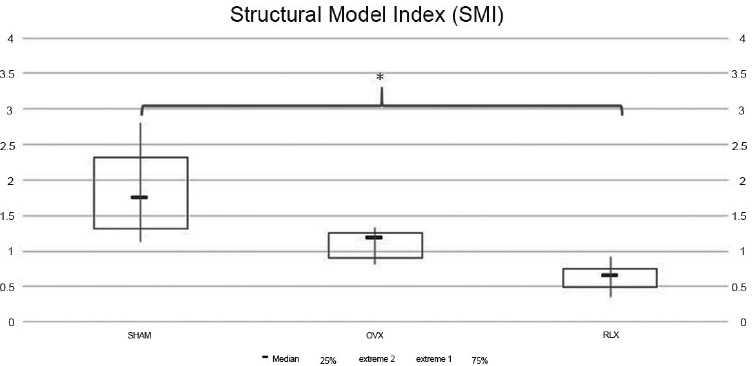
Figure 9- Chart with mean and standard deviation showing that RLX group had value closer to zero compared to SHAM group, which showed value closer to three (P>0.05). The asterisk represents a statistically significant difference between SHAM and RLX